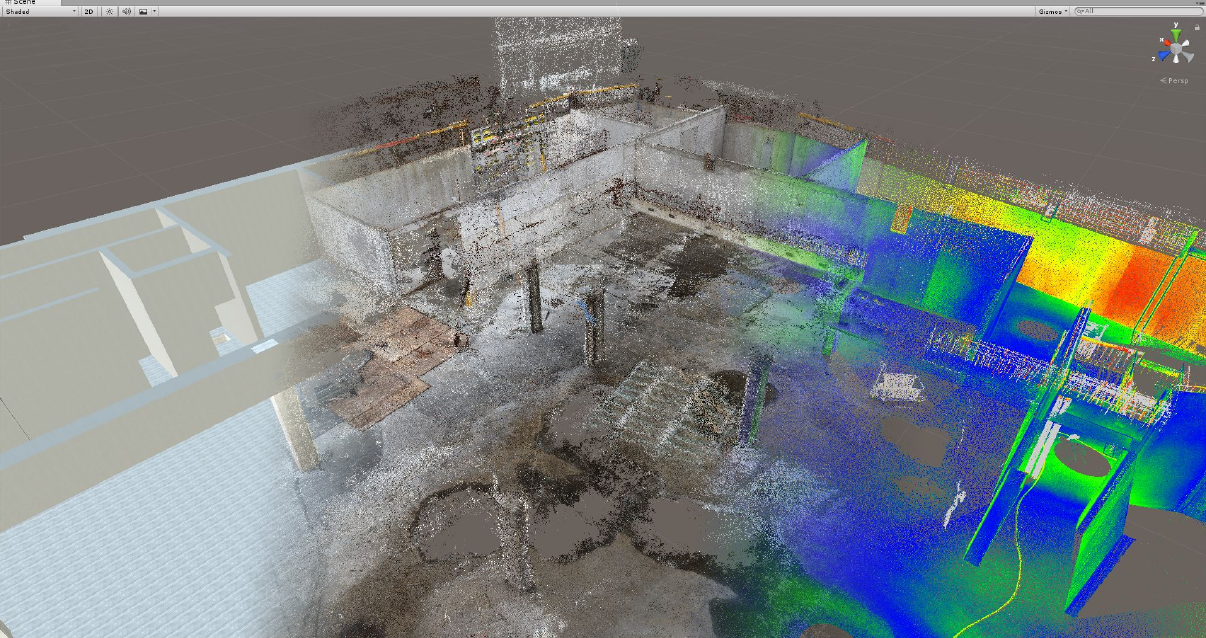
Figure 1: Three datasets (as-design BIM model, photogrammetry point cloud and deviation analysis on laser scanning point cloud) are successfully imported into the Unity gaming engine. The models overlay precisely due to a common reference frame as is proven by the non-altered point of view. (Remark: this figure is a photoshopped combination of the three original images, from an unaltered point of